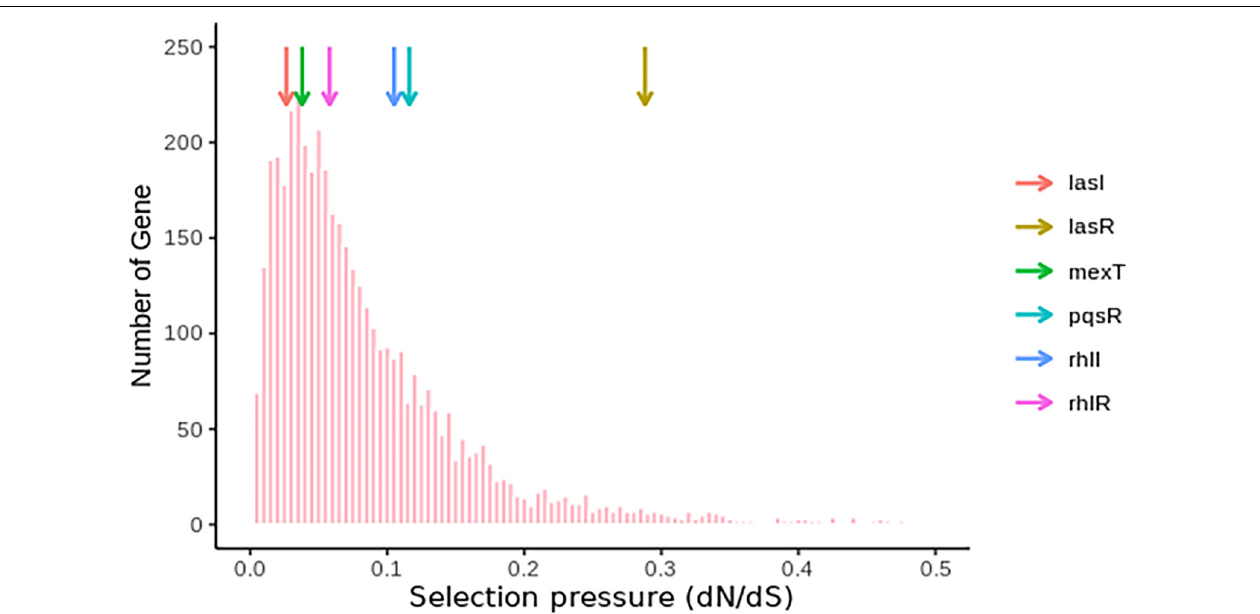
FIGURE 5 | Nucleotide substitution rates of single-copy genes in P. aeruginosa. The colored arrows show the positions of the genes and their respective dN/dS